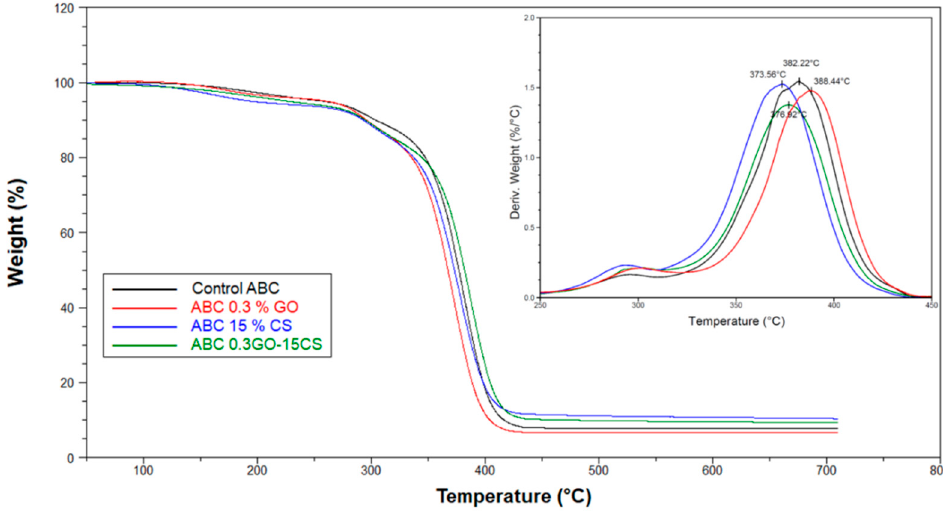
Figure 5. TGA and DTGA (inset) curves for experimental ABCs.